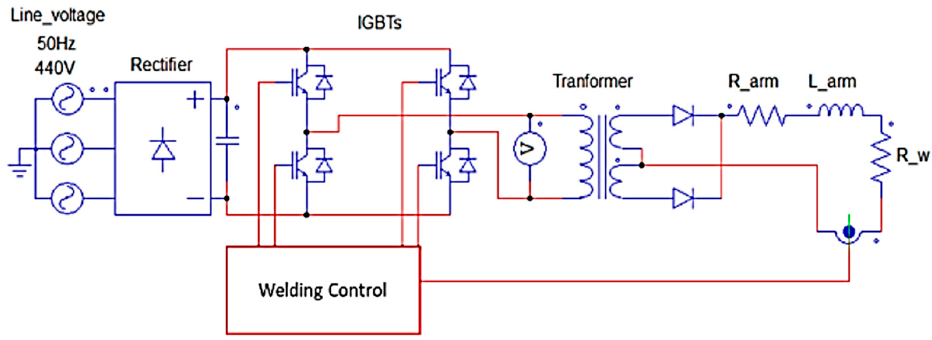
Figure 1. Schematics of MFDC